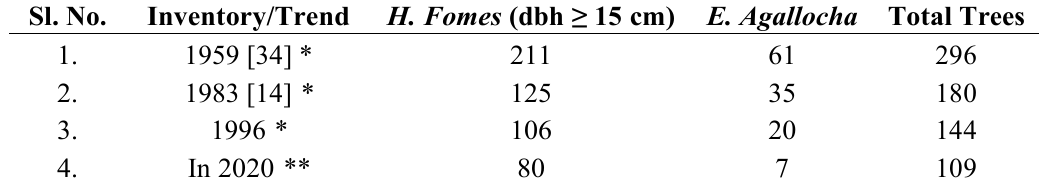
Table 5. Inventories * and Trends ** (estimated using “Table Curve 2D” Program) of BSMF growing stocks (no. per